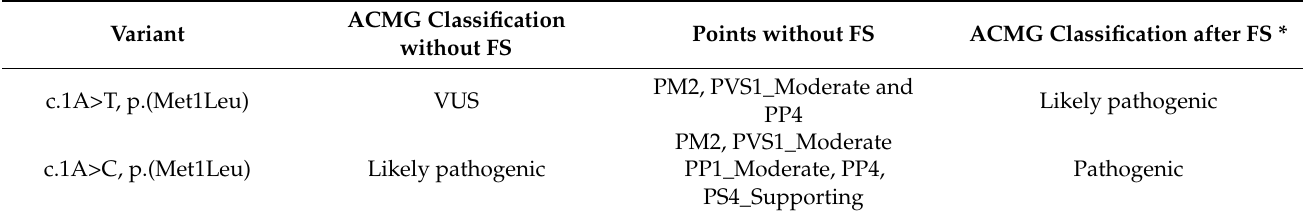
Table 2. ACMG/AMP classification with and without the functional data.